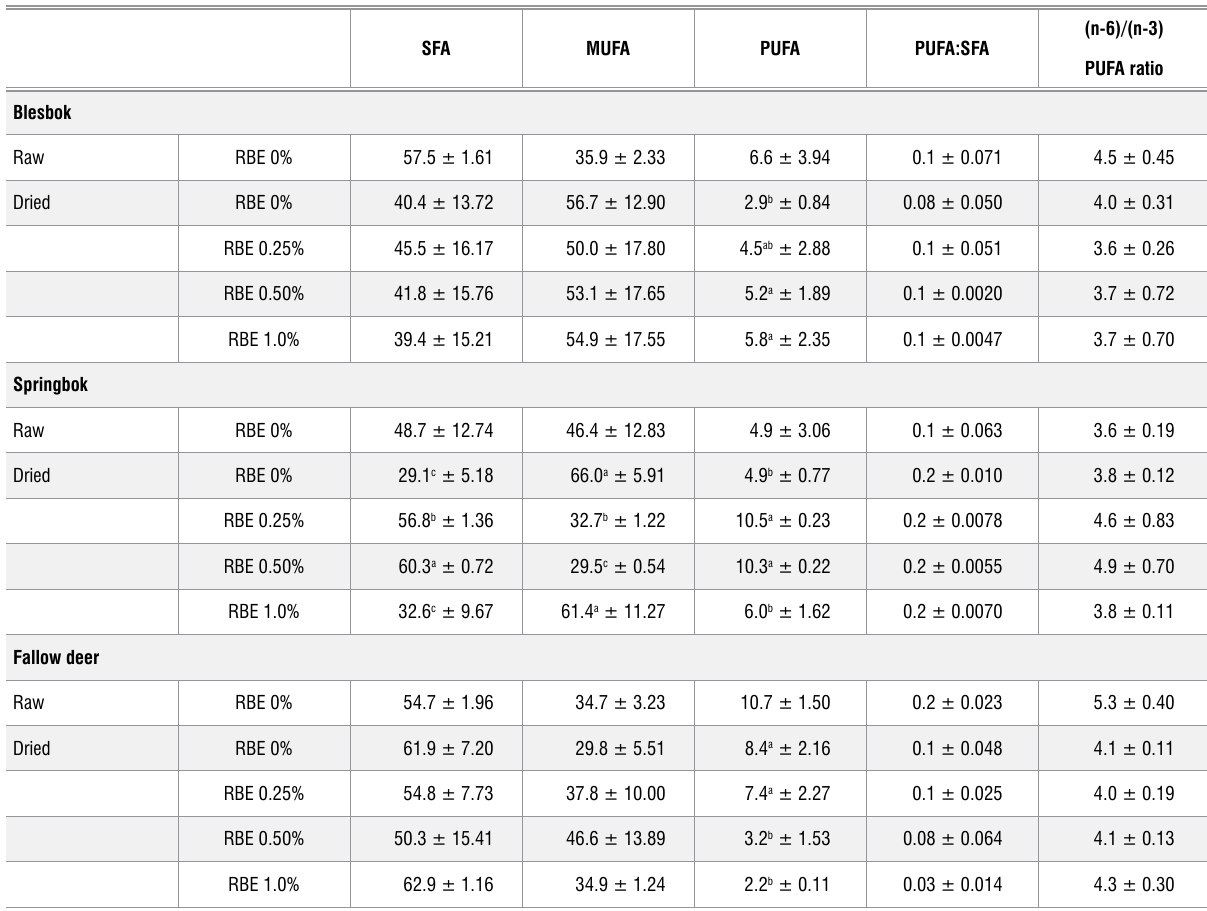
Table 3: Total fatty acid profile (%)±s.d. of game droëwors produced with increasing rooibos extract (RBE) levels